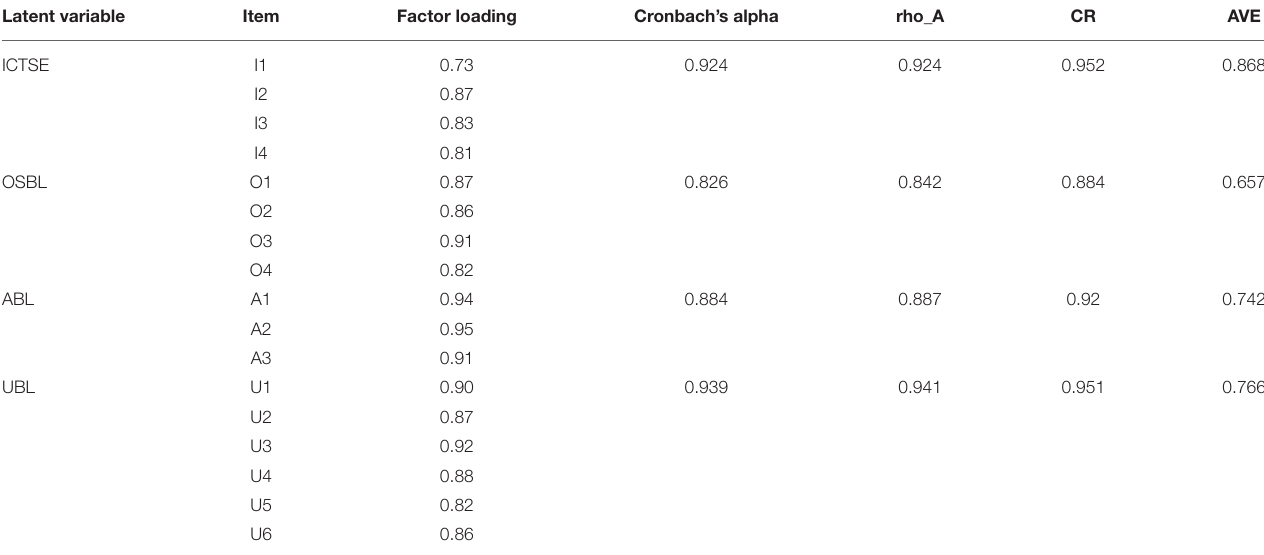
TABLE 3 | Results of the measurement model.